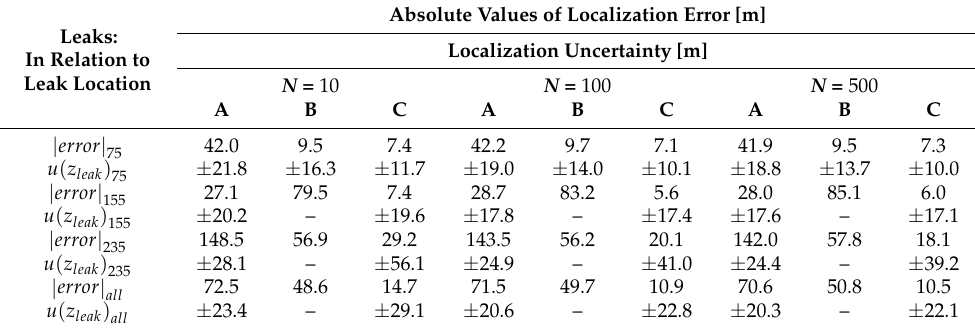
Table 3. Averaged absolute values of localization errors and averaged values of localization uncertain- ties depending on the leak location, including the different number N of data samples used for pres- sure estimation, as well as following the sensor configuration A, B or C in the localization procedure. Leaks: In Relation